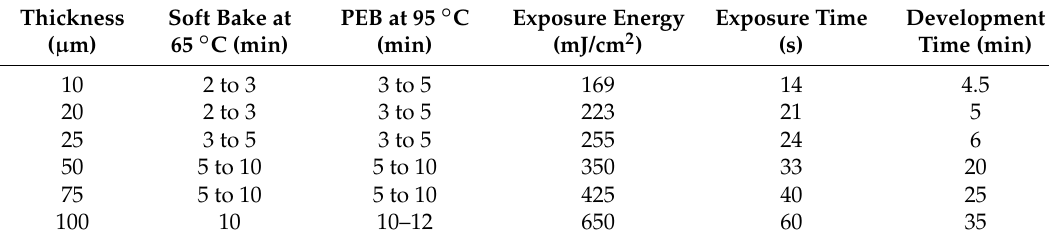
Table 1. Process parameters for ADEX